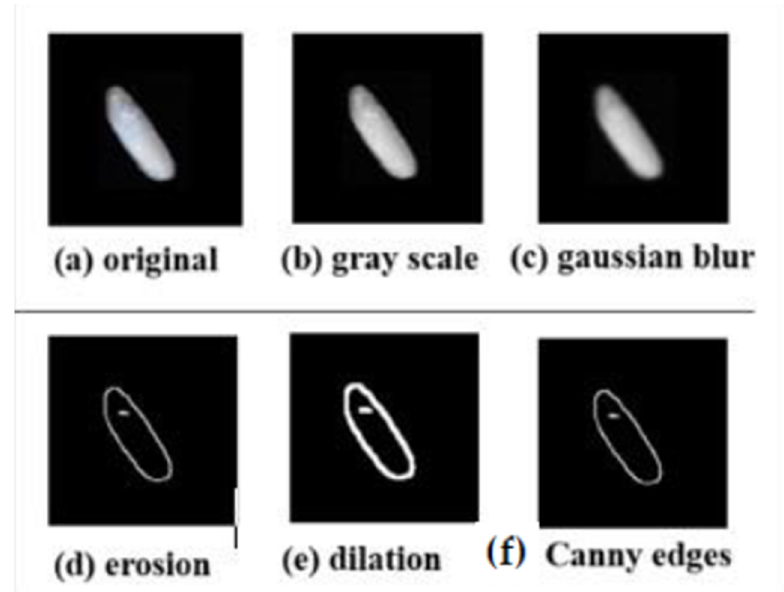
Figure 5. Image pre-processing stages for feature extraction of rice kernel.